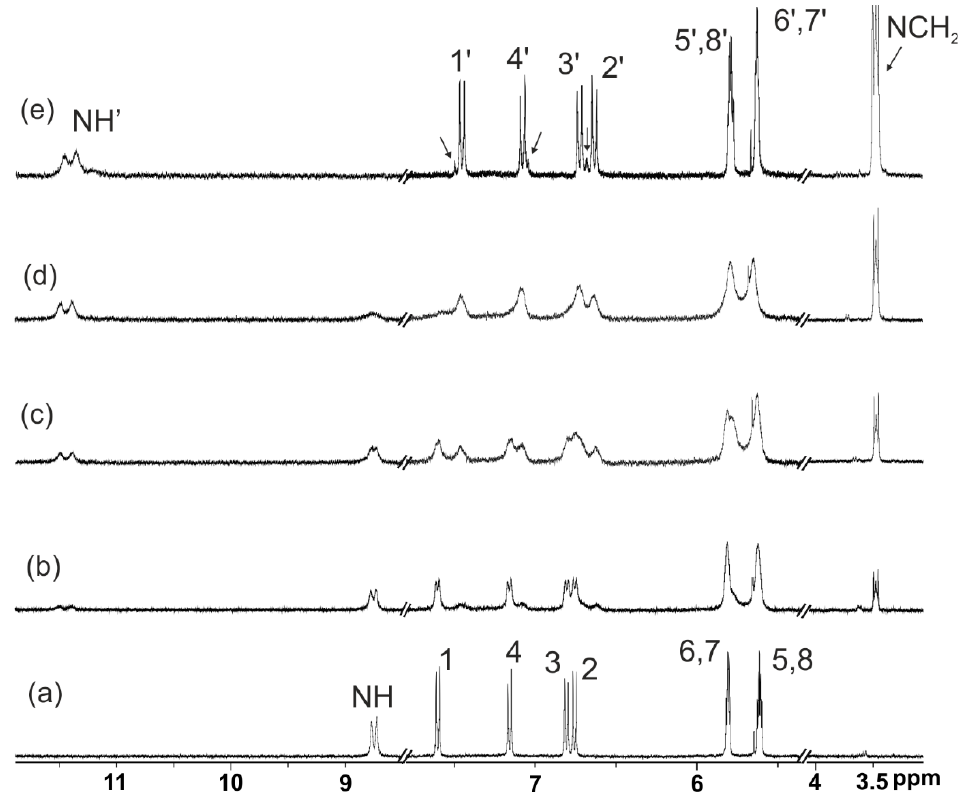
Figure 3. Selected regions of the 1 H NMR spectra (400 MHz, acetone-d 6 , 298 K) acquired during the titration of receptor 2Au (2.2 mM) with incremental amounts of TBACl: ( a ) 0 ( b ) 0.25 ( c ) 0.5 ( d ) 0.75 and ( e ) 1.2 equiv. Black arrows indicate the presence of a second set of proton signals.